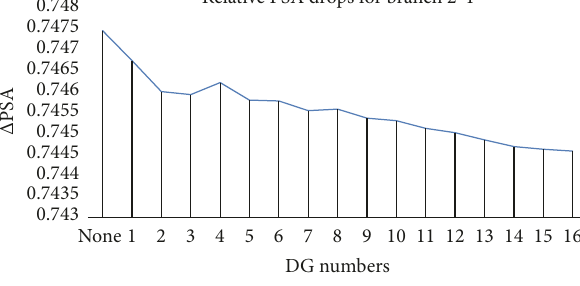
Figure 4: PSAs for adding one DG at different buses.